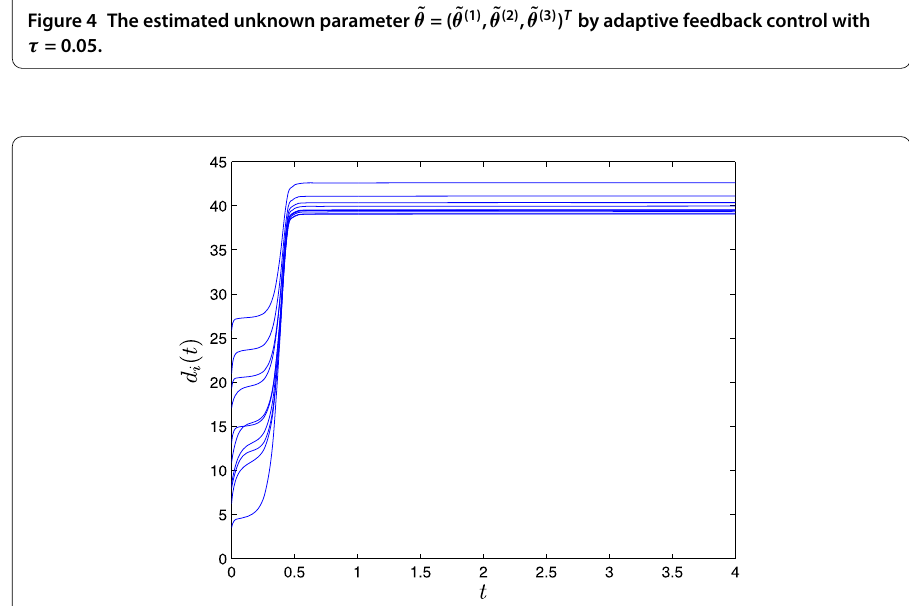
Figure 5 Time evolution of feedback gains d i ( t ) with h i = 10, i =